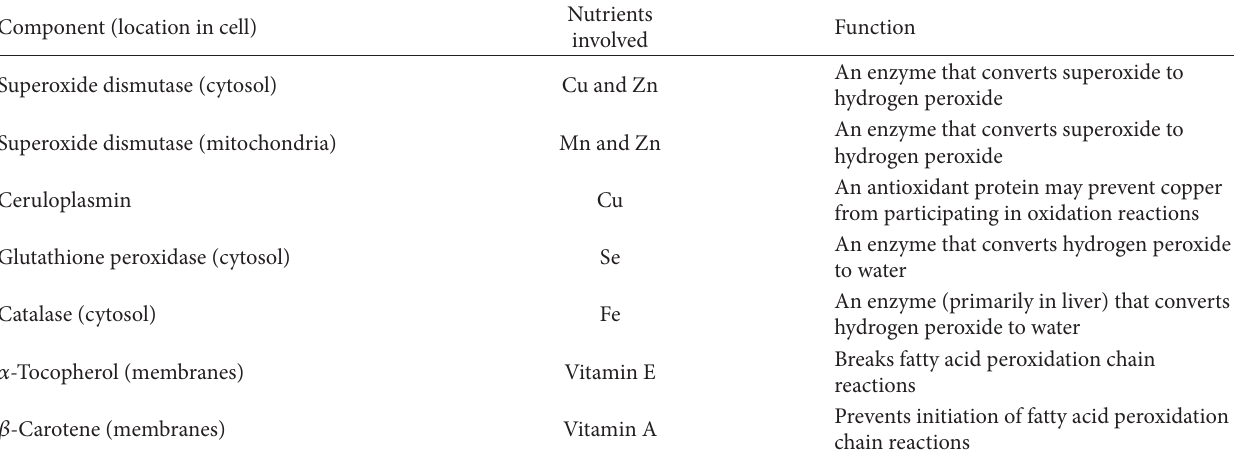
Table 1: Antioxidant systems found in mammalian cells